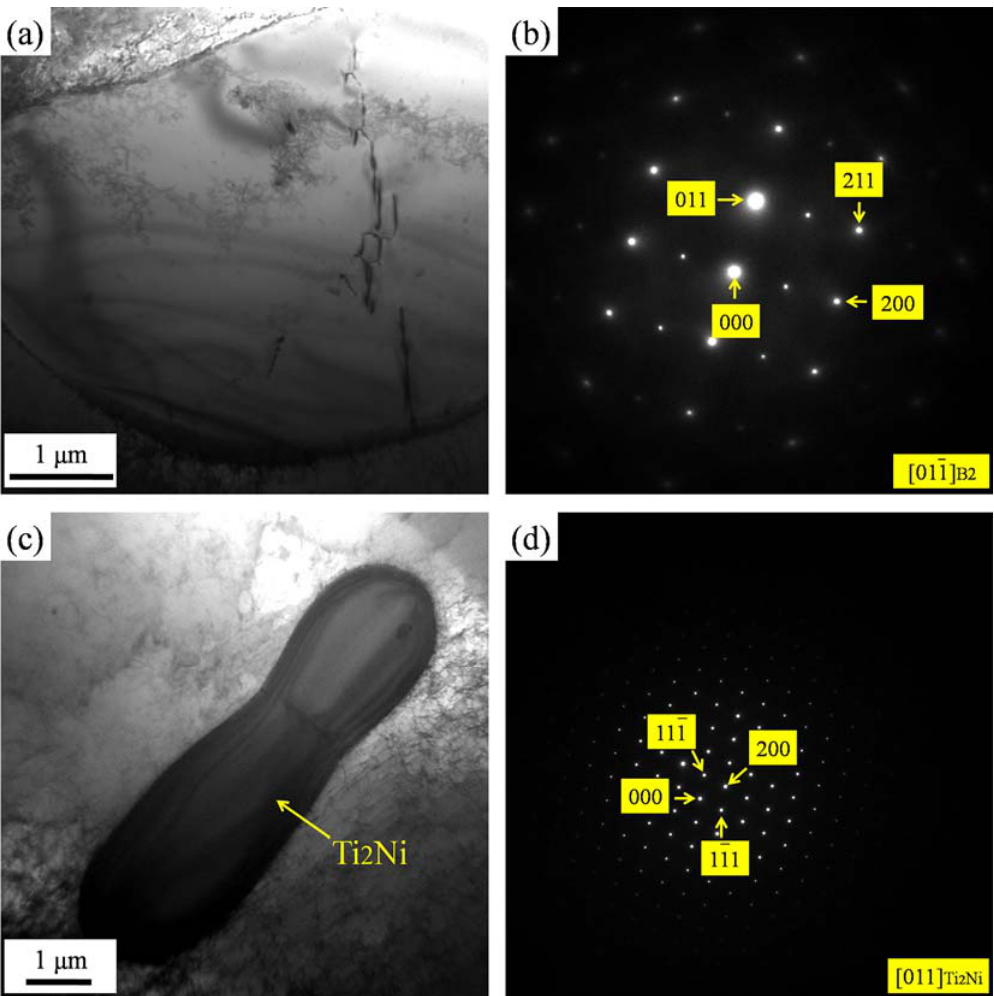
Figure 3. TEM (Transmission electron microscopy) micrographs of Ni 45 Ti 51.8 Fe 3.2 SMA (Shape memory alloy): ( a ) Bright field image showing B2 austenite matrix; ( b ) Diffraction pattern of B2 austenite matrix in ( a ); ( c ) Bright field image showing Ti 2 Ni precipitate; ( d ) Diffraction pattern of Ti 2 Ni precipitate in ( c ).